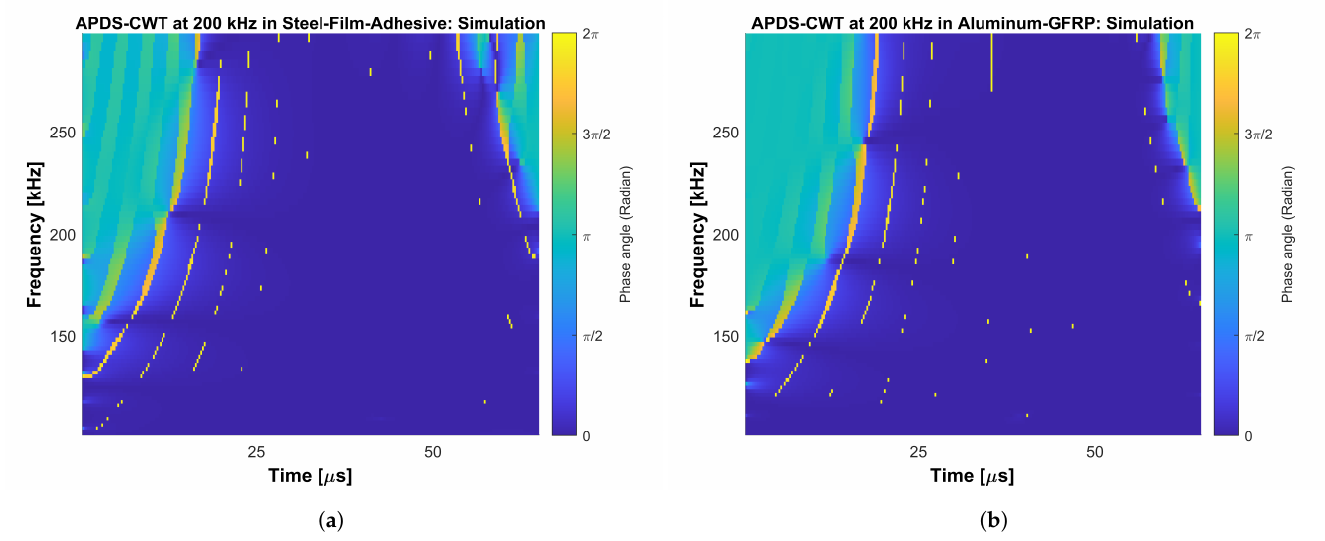
Figure 6. The APDS of the aluminum-GFRP plate and the steel-film adhesive plate at 200 kHz: the same characteristics as expected for signal group 2 can be identified. ( a ) APDS-CWT of the steel-film adhesive plate at 200kHz. ( b ) APDS-CWT of the aluminum-GFRP plate at 200kHz. The APDS-CWT for the aluminum-GFRP laminate show qualitatively the